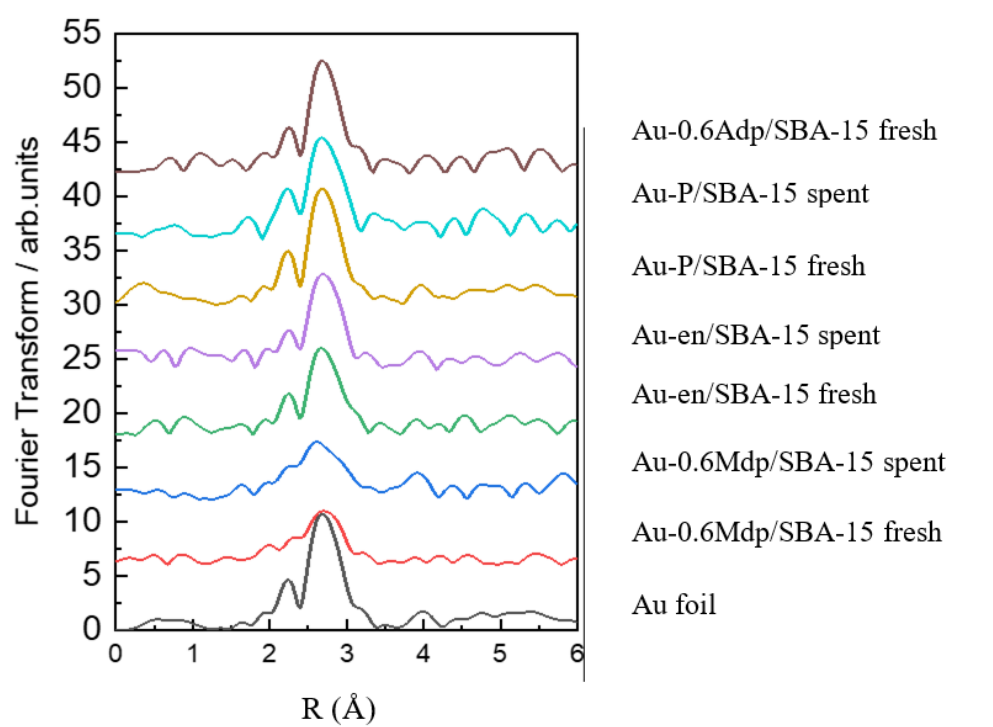
Figure 5. Magnitude of the k 3 -weighted Fourier transformed EXAFS data for all samples.